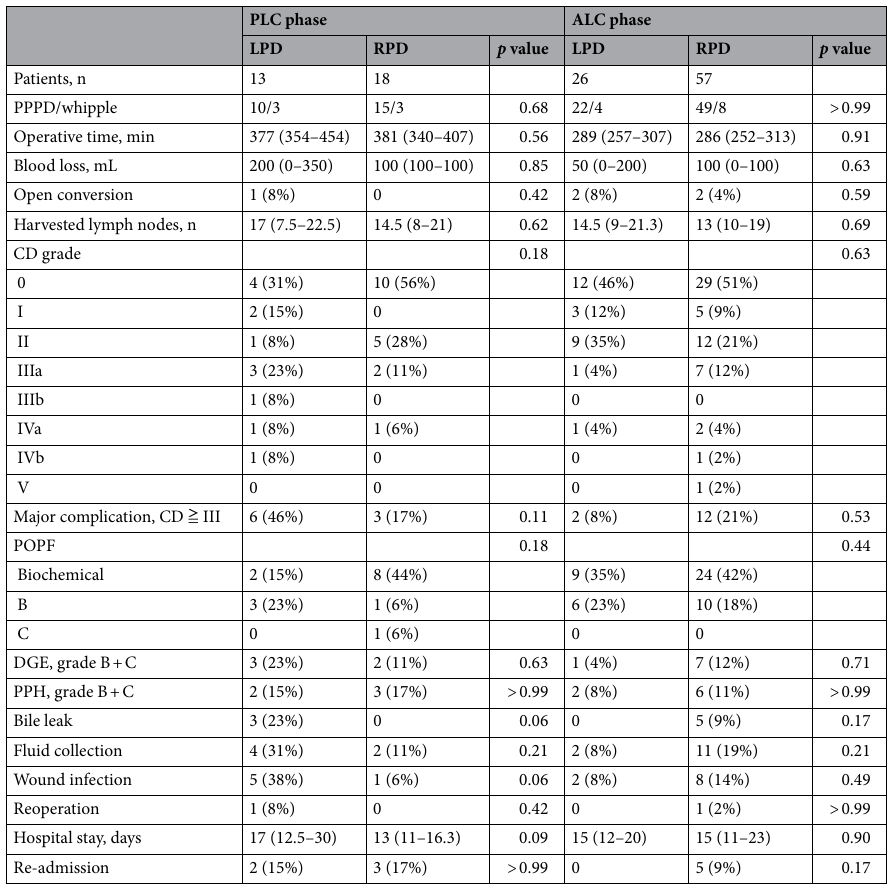
Table 5. Perioperative outcomes between approaches in the PLC and ALC phase. PLC pre-learning curve, ALC after-learning curve, PPPD pylorus preserving pancreaticoduodenectomy, CD Clavien–Dindo, DGE delayed gastric emptying, PPH postpancreatectomy hemorrhage, POPF postoperative pancreatic